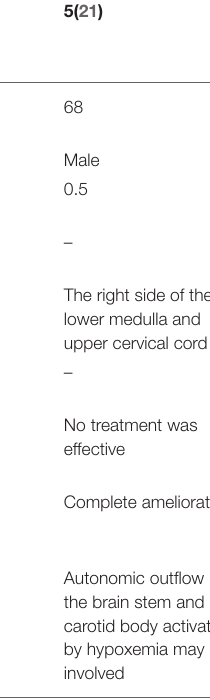
TABLE 1 | Cluster-like headache secondary to anamnesis of sphenoid ridge meningioma: a review of the literature. Case and